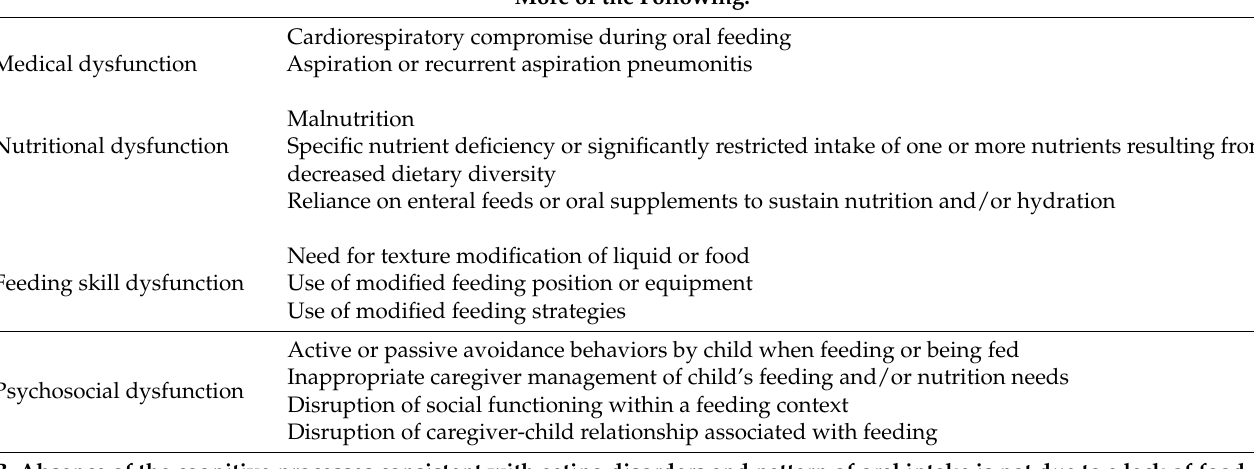
Table 1. Diagnostic criteria for Pediatric Feeding